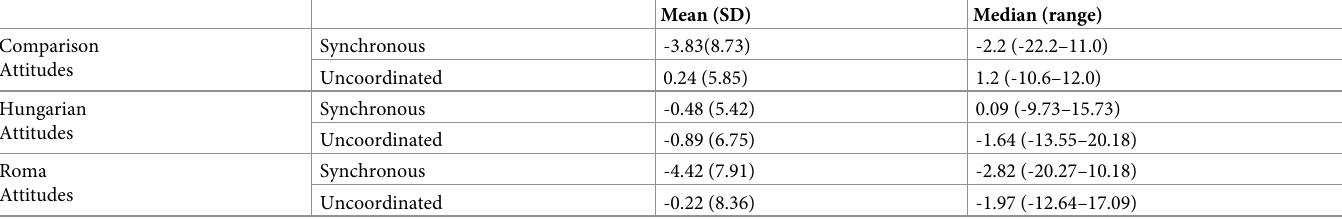
Table 4. Descriptive statistics for the attitude change